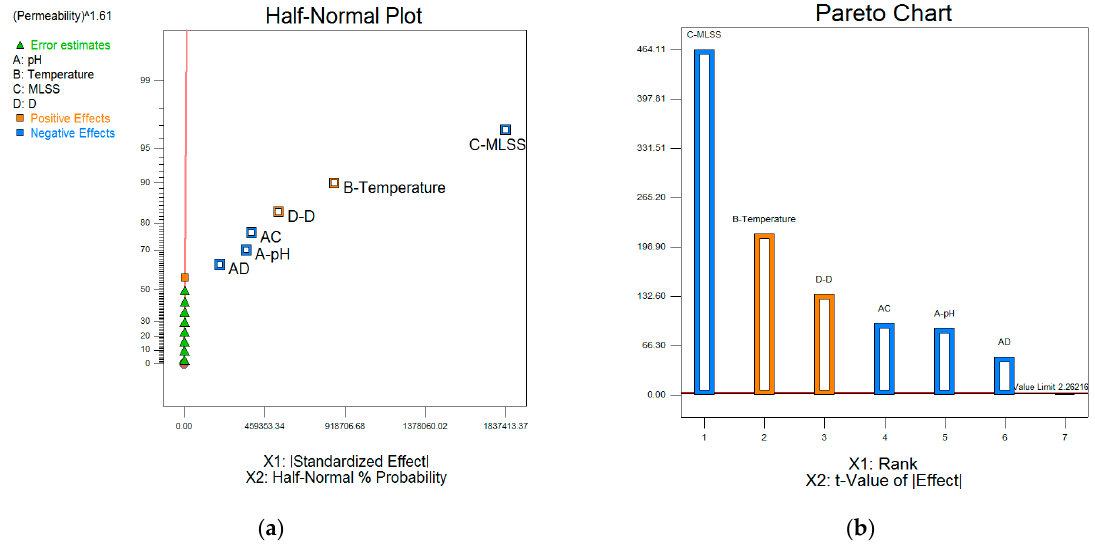
Figure 15. The selection of the effects to be modelled: ( a ) half-normal plot of effects; ( b ) Pareto chart. The half-normal plot of effects demonstrates the absolute values of the squares of effects plotted against their cumulative normal probabilities [93,94]. The terms, which were selected as significant, that is, included in the model, were C (MLSS), B (temperature), D (coagulant dose), AC (the interaction effect of pH · MLSS), A (pH) and AD (the interaction effect of pH · coagulant dose). The negligible effects lined up at the red “error line” close to zero (Figure 15a). all the selected effects are higher than Bonferroni limit = 3.46159 and t-value limit = 2.26216 (t value can be identified as a magnitude of the difference relative to the variations in the data [95]).